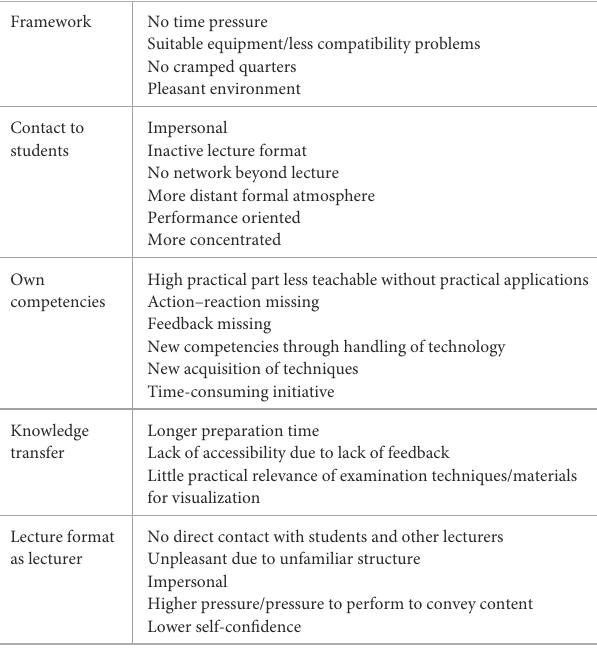
TABLE 2 Representation of the lecturers’ opinions and qualitative results.